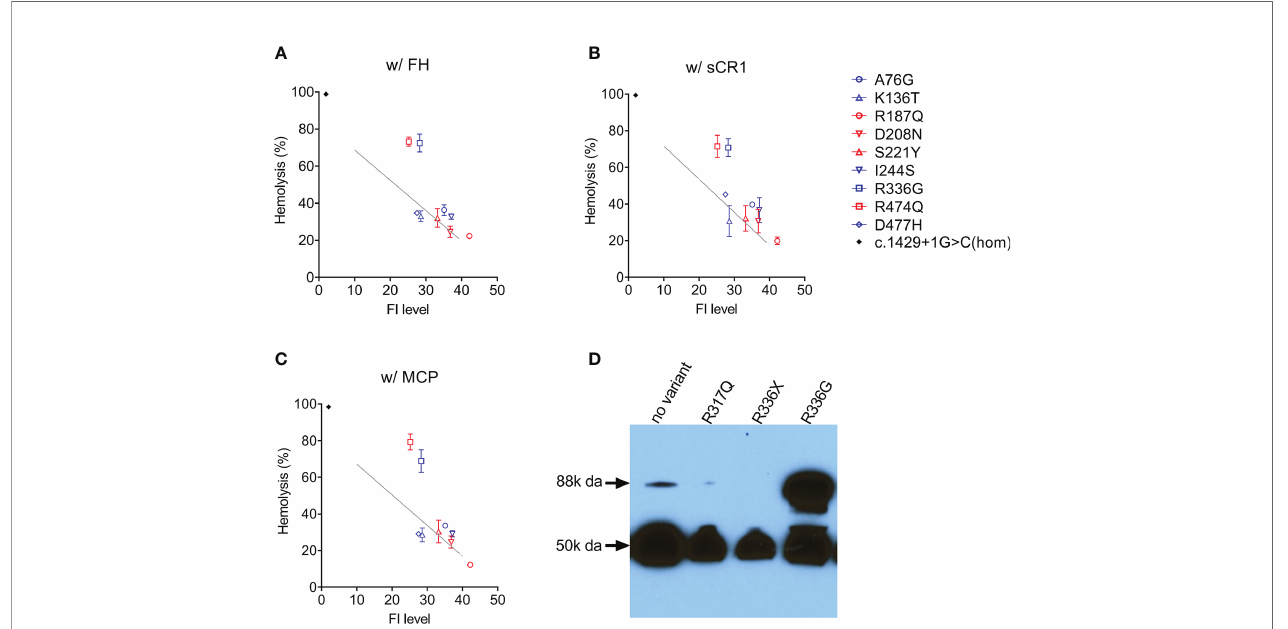
FIGURE 3 | Assessing FI function. In the presence of a cofactor (A) FH 50 nM; (B) sCR1 25nM; (C) MCP 50nM, C3b cleavage activity by FI in patient serum (diluted 1:32) is measured using C3b-decorated sheep erythrocytes. Non-cleaved C3b is developed by the addition of both FB/FD to form C3 convertase and rat-EDTA serum as a source of C5-C9. Percent hemolysis is calculated and plotted as a function of FI concentration determined by ELISA. The grey line in each fi gure serves as a normal reference line calculated from a normal sample (FI concentration, 40 mg/L) with serial dilutions. Serum from a CFI c.1429+1G>C homozygote (FI is undetectable) serves as a positive control (black dot). (D) Circulating FI by a Western blot. Patient sample (1:80 diluted in PBS) with reducing reagent separated on a 4-15% polyacrylamide gel and transferred. FI was visualized by an antibody speci fi c to the heavy chain (50k Da). CFI p.Arg336Gly results in an unprocessed single chain (88k